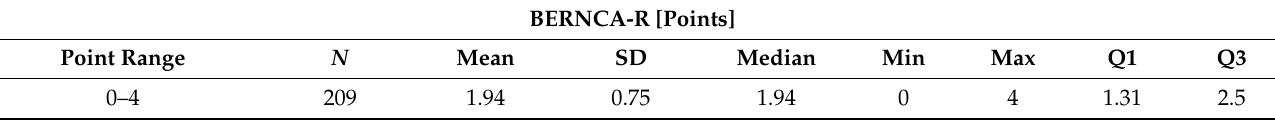
Table 2. Mean total BERNCA score.